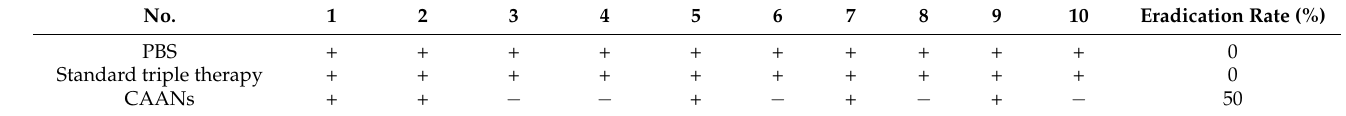
Table 3. In vivo eradication rate of different treatments of H. pylori with the MIC value of 0.5 µ